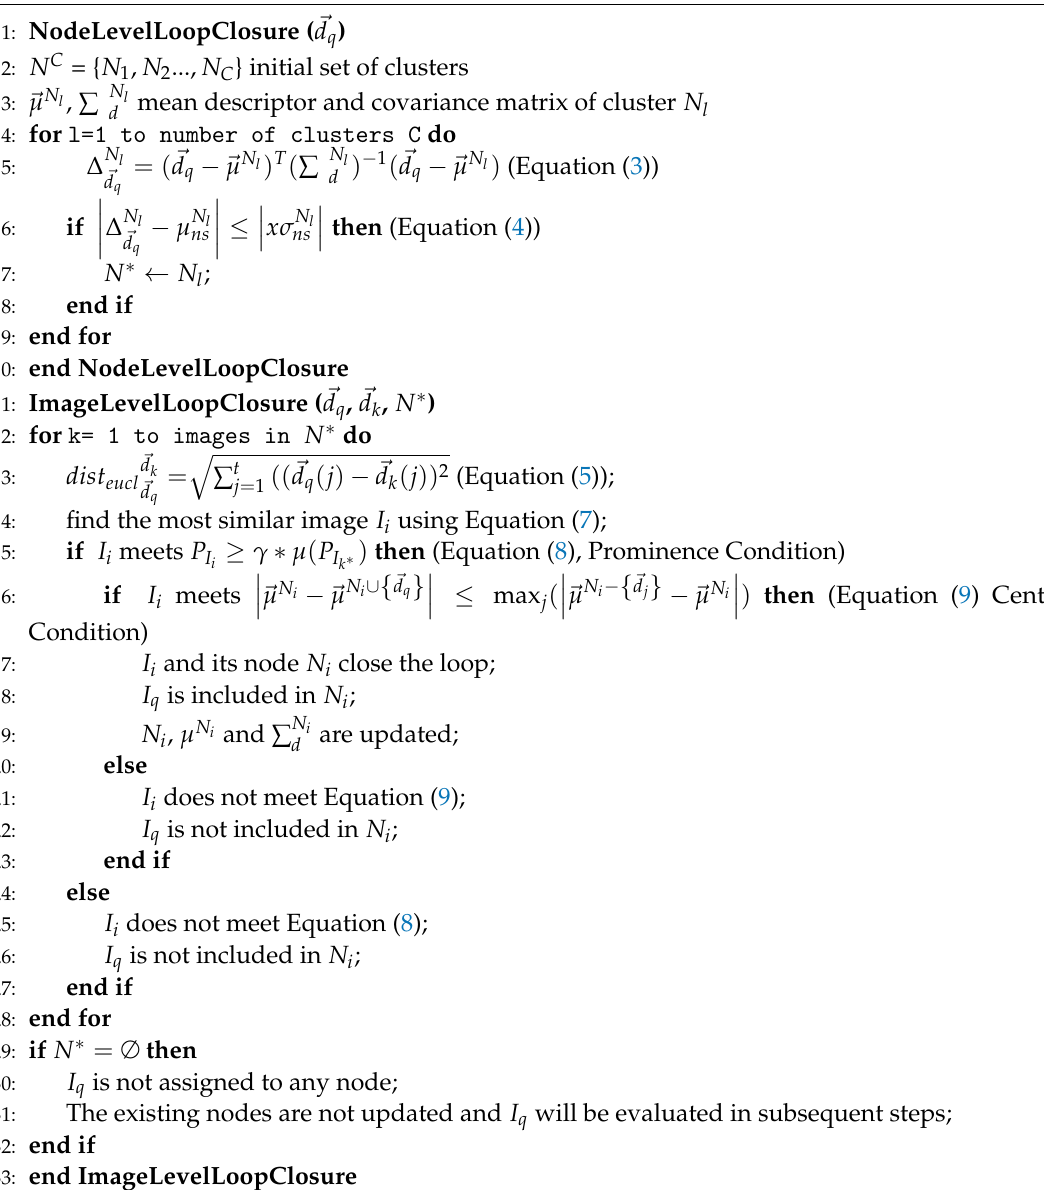
Algorithm 1 Pseudocode for Node and Image Level Loop Closure, applying Prominence and Centroid